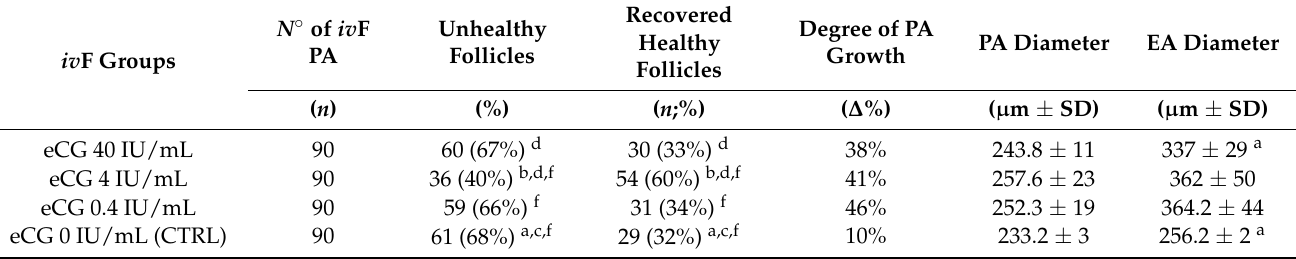
Table 1. eCG dose effect influence on iv F outcomes: quantitative and qualitative PA follicle performances.